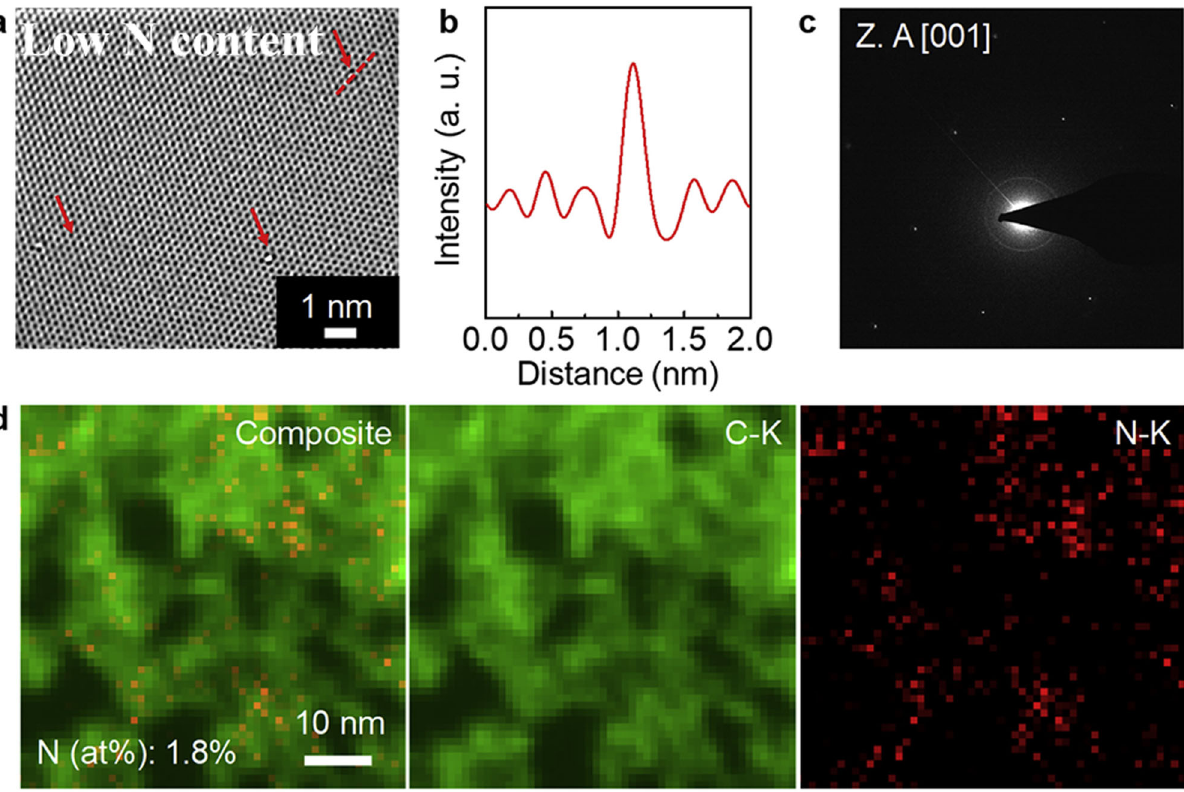
Fig. 6 Transmission electron microscopy imaging on NDG with low N content (<2 at.%). a Bandpass- fi ltered high-resolution TEM image, b height pro fi le of the dotted red line in panel a , c selected area electron diffraction pattern, and d elemental mapping images using electron energy loss spectroscopy ( reproduced from 26 with permission from